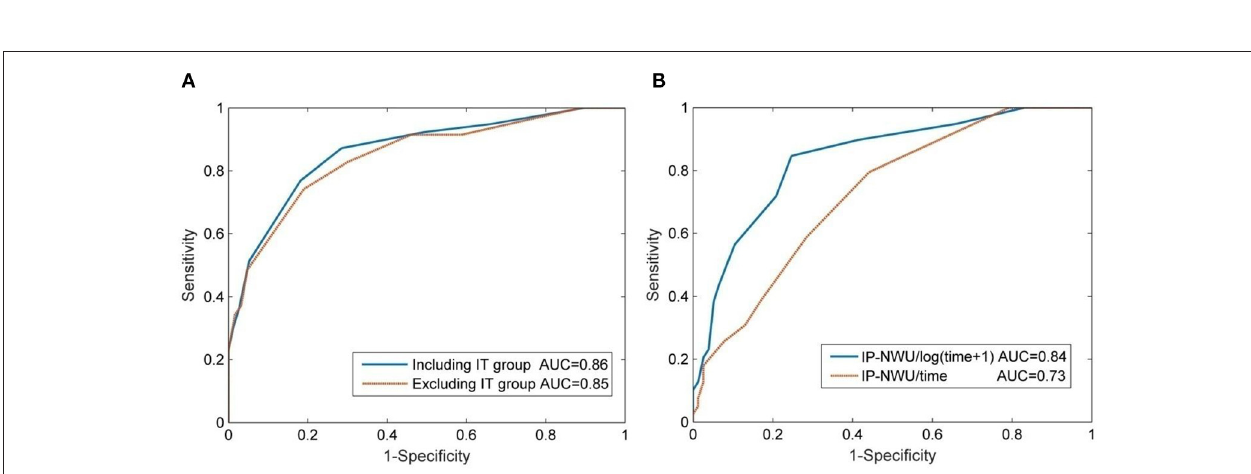
FIGURE 4 | Prediction of malignant cerebral edema (MCE) by IP-NWU and its confounders. (A) ROC curve of prediction of MCE by IP-NWU for groups including patients who underwent interventional thrombectomy (IT) and excluding patients who underwent IT; (B) ROC curve by IP-NWU/time and by IP-NWU/log(time + 1).